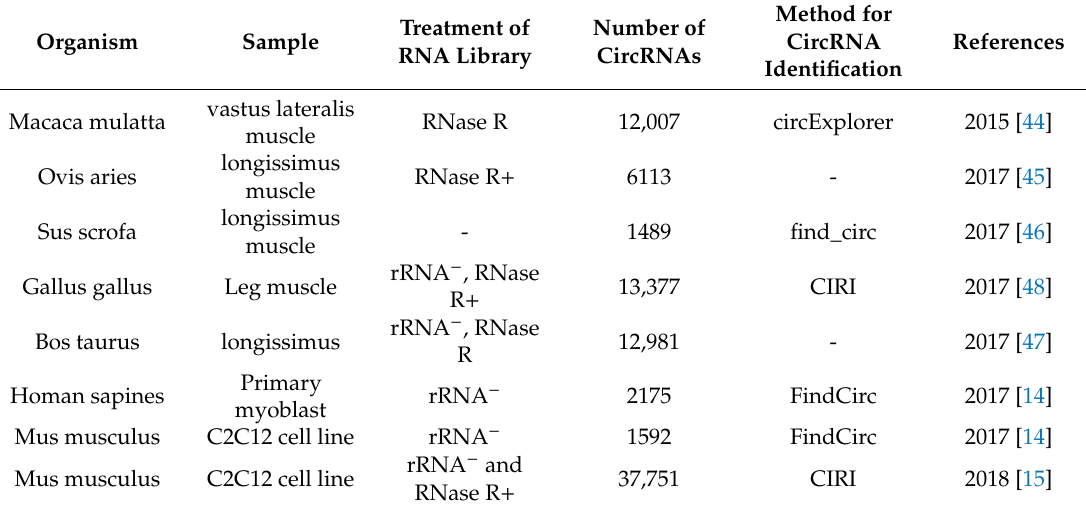
Table 1. Overview of circRNAs identified in skeletal muscle on the basis of RNA